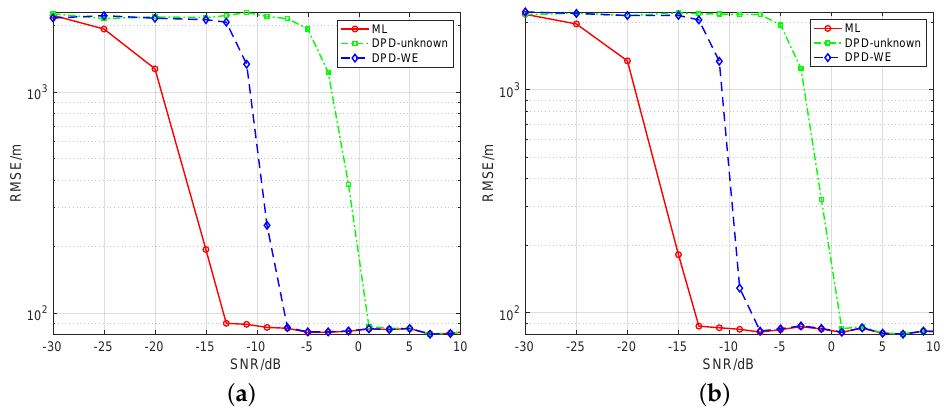
Figure 9. RMSE vs. SNR for the three localization algorithms of ML, DPD-unknown and DPD-WE with transmitting LFM pulses of noncoherent and coherent modulations: ( a ) noncoherent modulation, ( b ) coherent